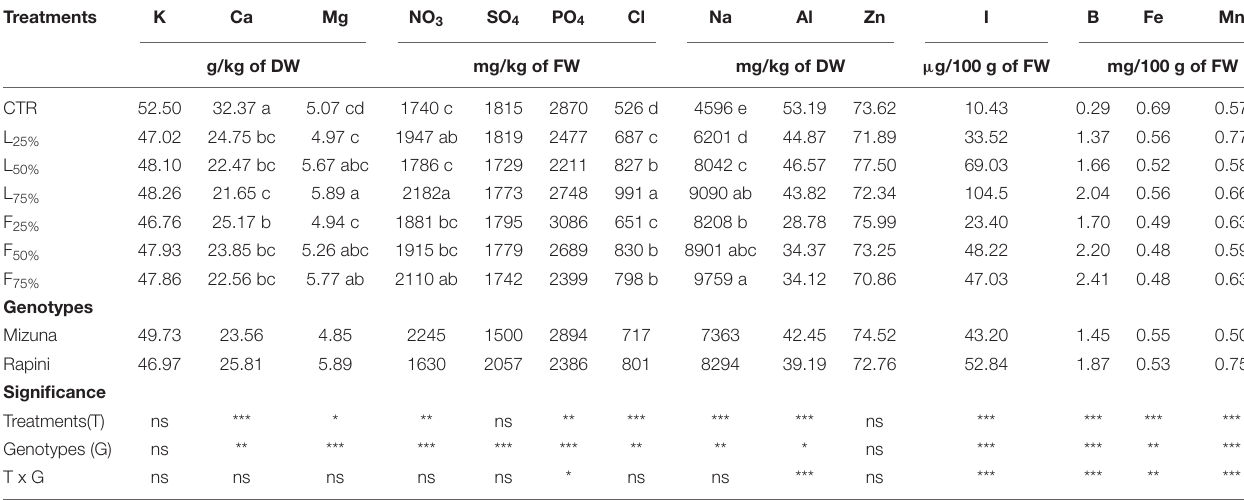
TABLE 7 | Mineral composition of Brassica rapa L. Mizuna and Rapini group microgreens, produced in greenhouse, as effected by Posidonia oceanica (L.) Delile (PO) leaves (L) and fibers (F) in the growing media.